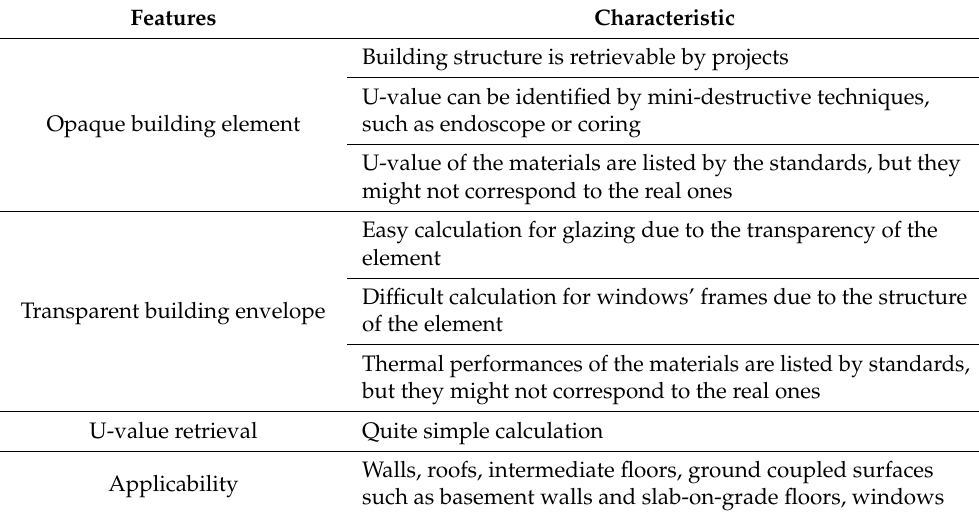
Table 4. Characteristics of the theoretical method (source: authors’